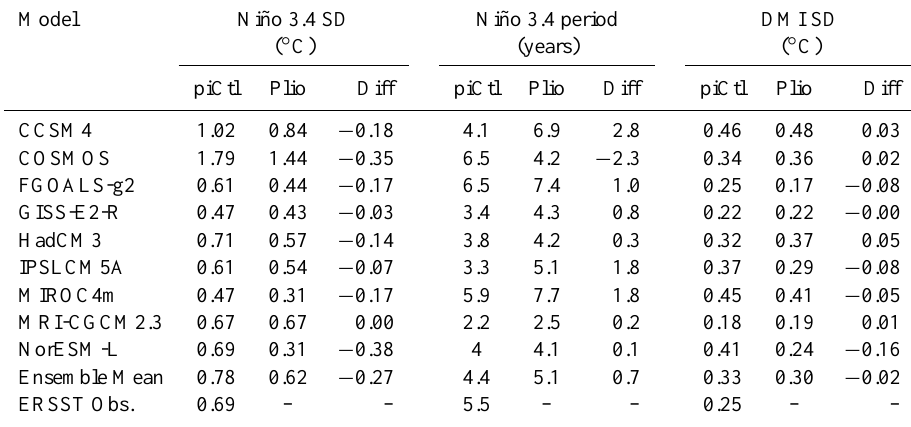
Table 2. Properties of area-averaged sea surface temperature indices (see Sect. 2.2 for details). The period listed below is that with the greatest spectral power. The preindustrial and Pliocene simulations, along with the difference between them, are denoted by piCtl, Plio and Diff, respectively.